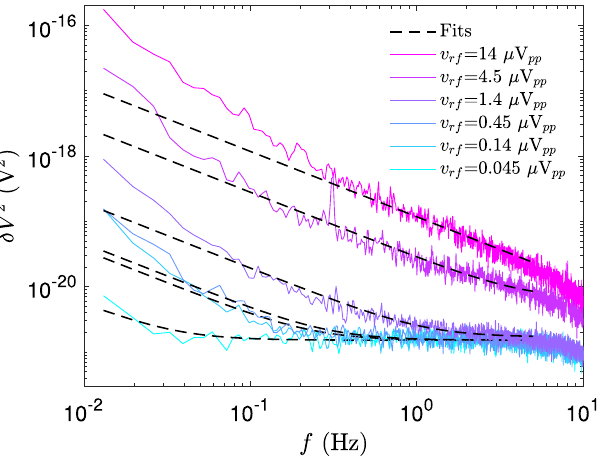
2 2.3 10 10 cm Figure 3. Noise spectra at n g close to Dirac point in terms of squared voltage fluctuation − = − × δ V 2 at the sample measured using rf carrier voltages specified in the inset. All of the noise spectra are measured at 35 mK temperature. The dashed lines and curves denote the 1/ f fits with background noise taken into 17 account as discussed in the text. In this measurement the number of points was 2 which facilitates a minimum 2 frequency of 13 mHz after omitting the lowest three points. The frequency bin for δ V corresponds to 3.28 mHz.